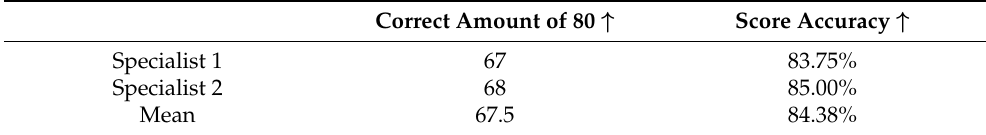
Table 4. Accuracy of scores from two